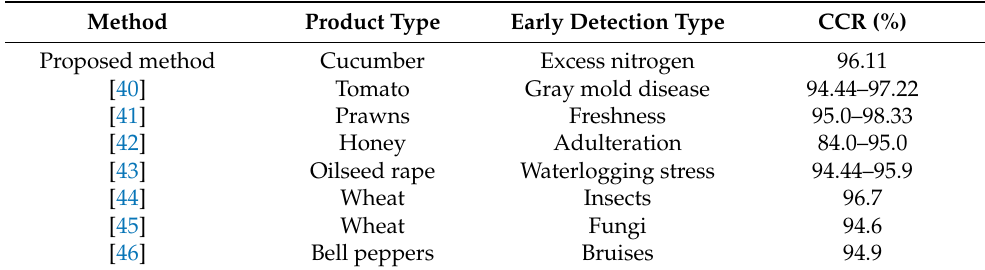
Table 9. Comparison of the results obtained in this study with other